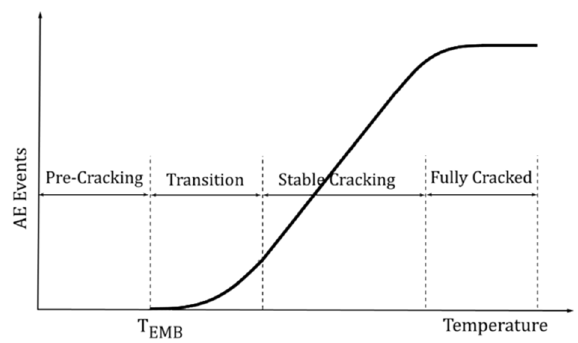
Figure 11. Schematic diagram of AE cumulative events vs. temperature showing four different regions for asphalt concrete materials.